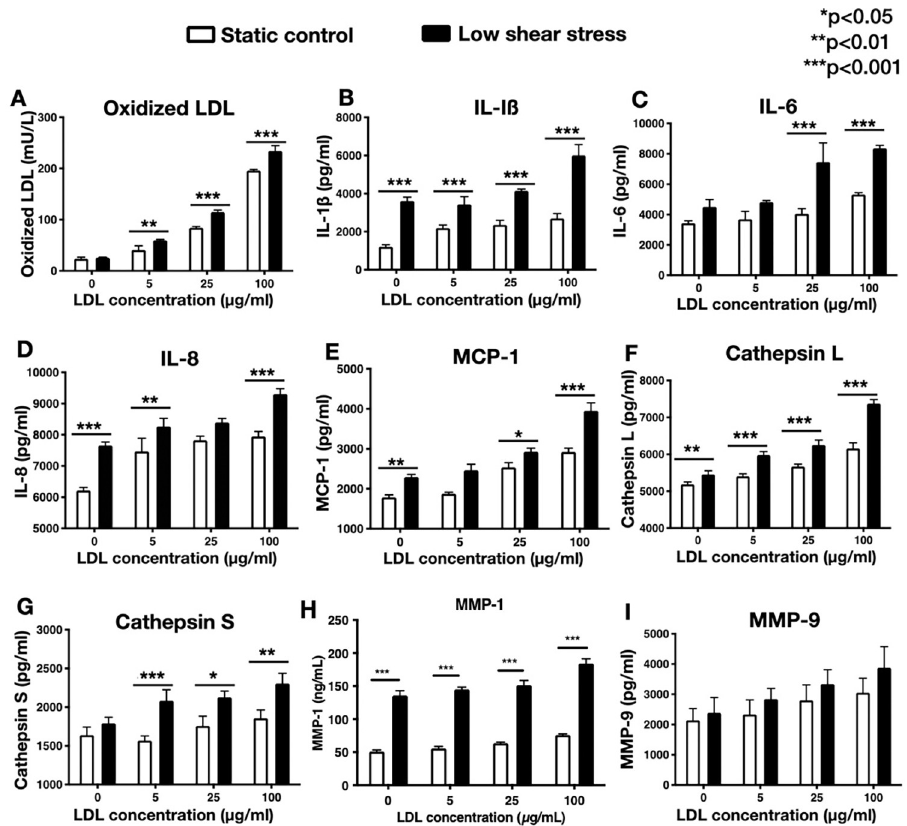
Fig 8. Effects of low shear stress and native LDL on oxidized-LDL and expression of pro-inflammatory molecules and matrix-degrading enzymes. Dose-response effect of native (non-oxidized) LDL on the quantities of oxidized LDL (A), MCP-1, IL-1ß, IL-6, IL-8, MMP-1 and -9, and cathepsins L and S (B-I), released into the medium of co-culture model #4 (white bars). Note that the pro-atherosclerotic effect of native LDL is significantly augmented by exposing the co-cultures to low shear stress (5 ± 3 dynes/cm 2 ) for 1 hour, prior to the addition of native LDL (black bars; ox-LDL: oxidized low-density lipoproteins, MCP: monocyte chemoattractant protein; IL: interleukin; MMP: matrix metalloproteinases) � p < 0.05; �� p < 0.01; ��� p < 0.001.